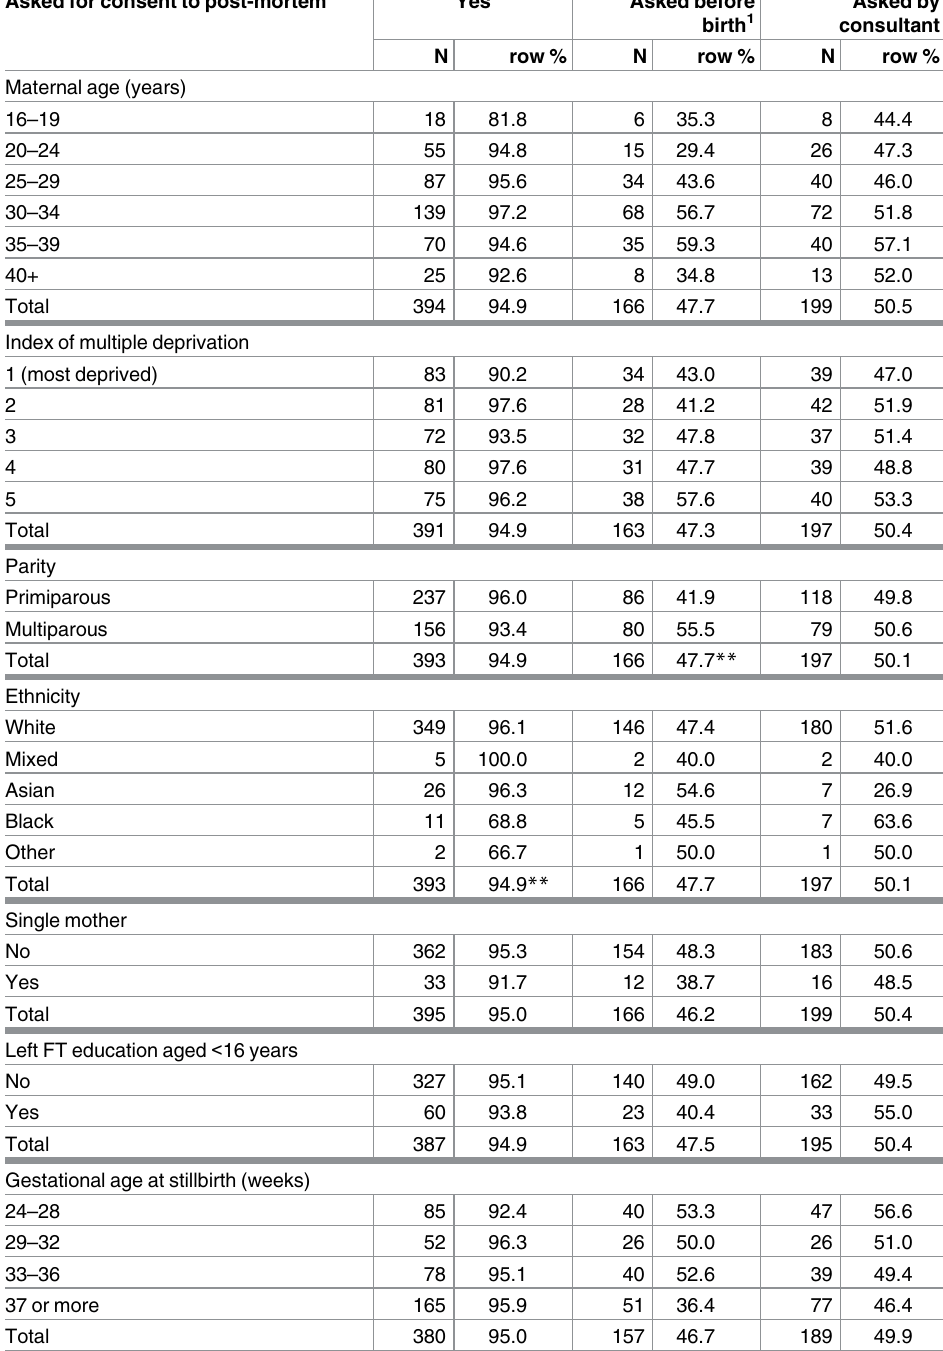
Table 1. Proportions of women asked for consent to a post-mortem by sociodemographic character- istics (Excludes 56 babies for whom a post-mortem was not necessary(as indicated by the mother), principally because of congenital